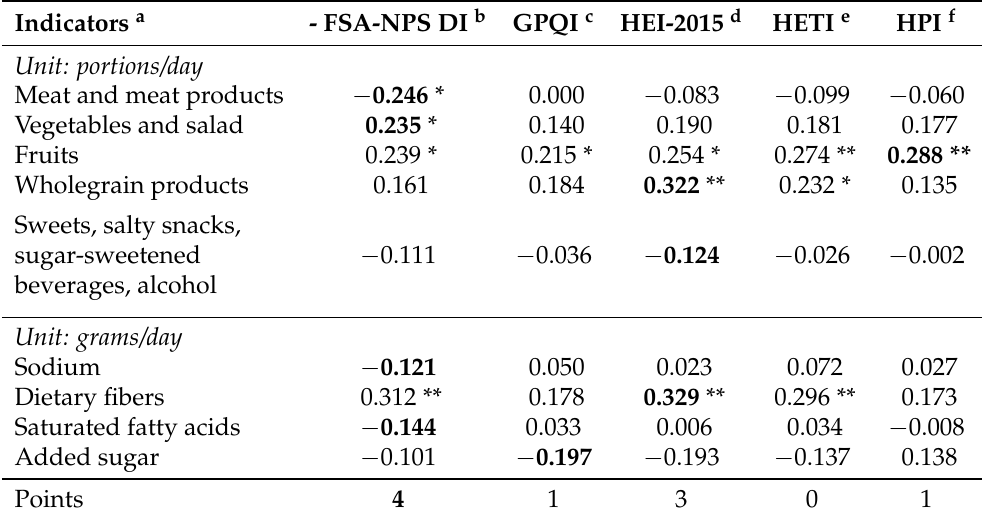
Table 4. Pearson correlation coefficients between food shopping quality indicators and absolute individual daily nutritional intake, N =